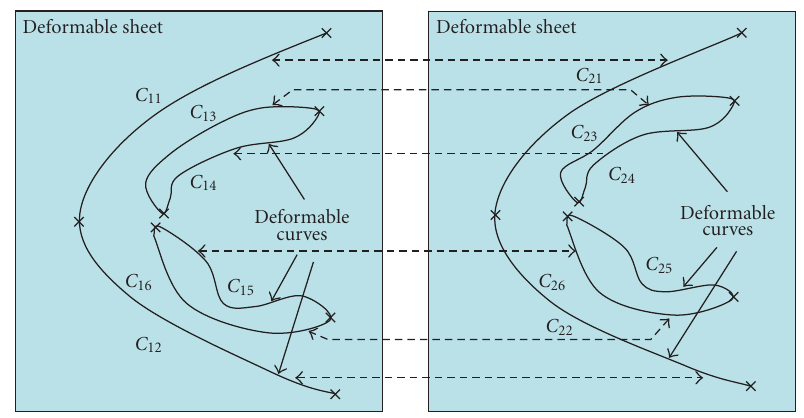
Figure 1: Configuration of the deformable sheet-curve